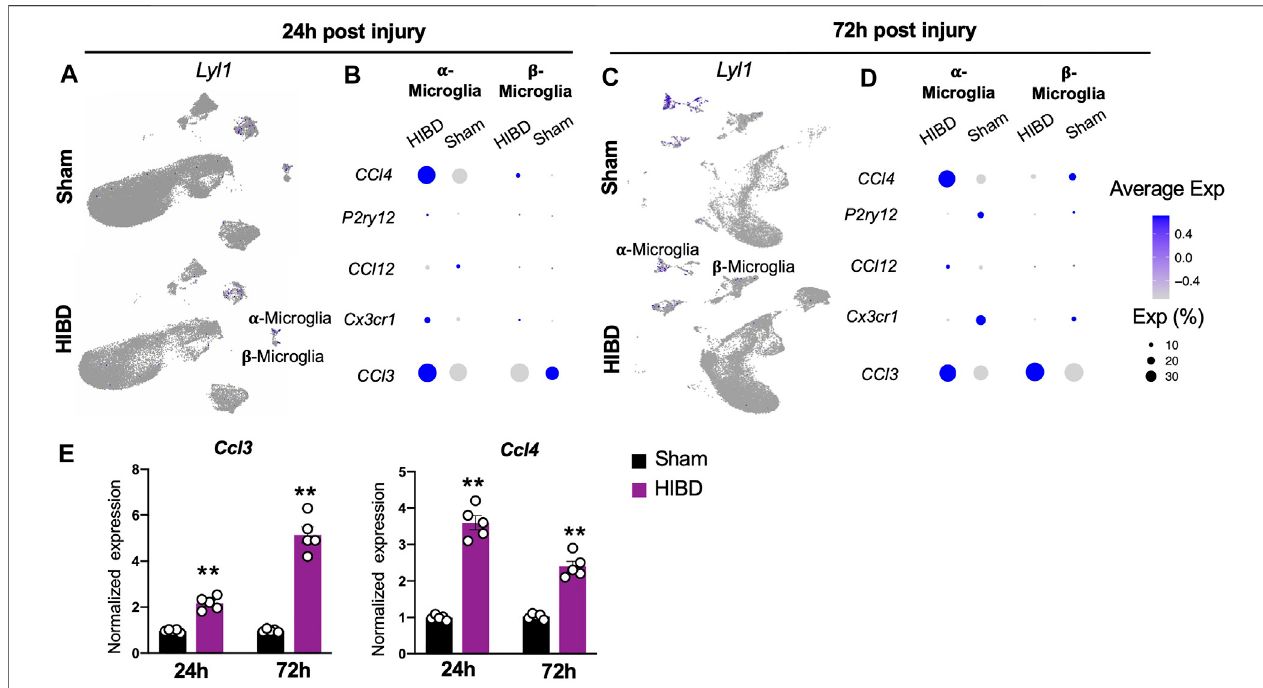
FIGURE6| Expressionchangesofcharacteristic genesindistinct microglia subtypespostneonatalHIBD (A,C) Feature plotsofamicroglia speci fi ctranscriptional factor ( Lyl1 ) over total pineal populations at 24 h (A) or 72 h (C) post sham or neonatal HIBD, respectively (B,D) Bubble plots showing expression levels of in fl ammation relatedgenesat24 h (B) or72 h (D) postshamorneonatalHIBD,respectively (E) Quanti fi cationofpinealRNAexpressionof Ccl3 and Ccl4 at24 hor72 hpostshamor neonatalHIBD,respectively.n=5,5forshamandHIBDanimals,foldchangesofRNAexpressionwere fi rstnormalizedtothoseof GAPDH ,andthentothoseinthe sham. Student ’ s t test, **, p <